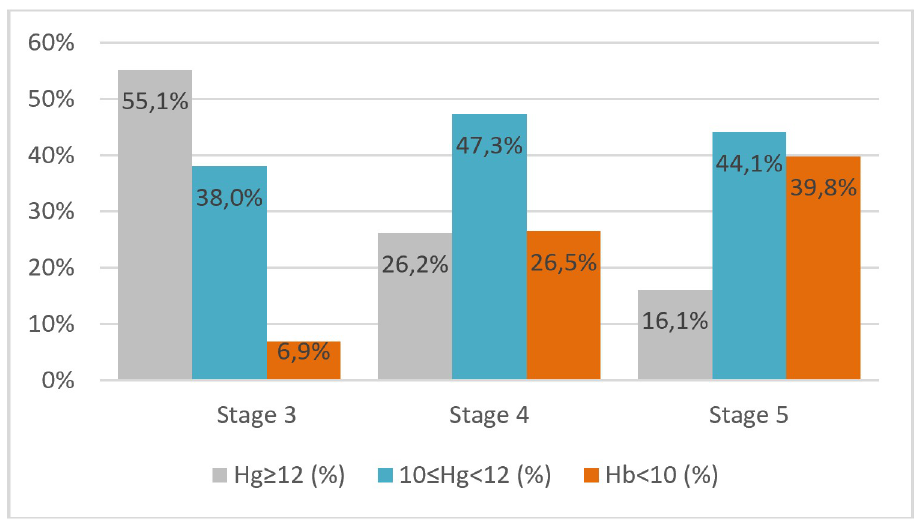
Fig 1. Prevalence of anemia based on staging of